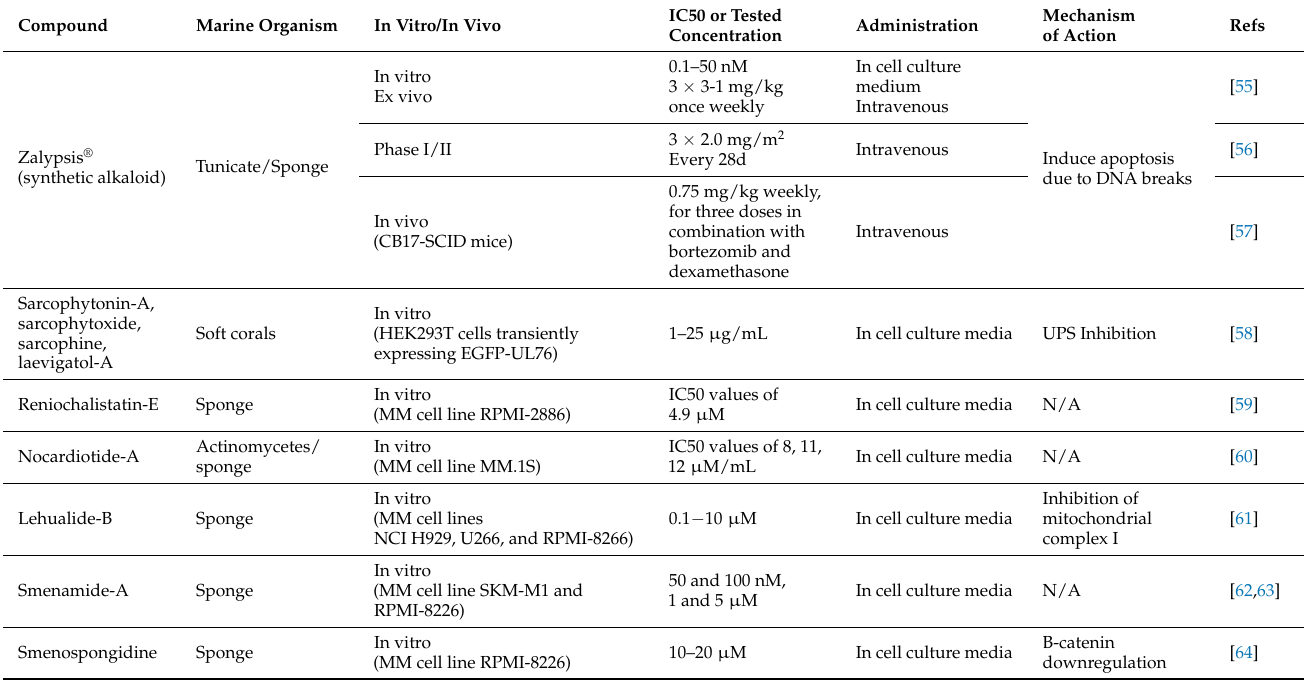
Table 3. Marine-derived compounds or extracts with activity in vitro or in vivo. Preclinical studies showing marine-derived compounds with antimyeloma activity in vitro/in vivo. Mechanism of ac- tion (when reported), marine organism, and experimental conditions are reported for each